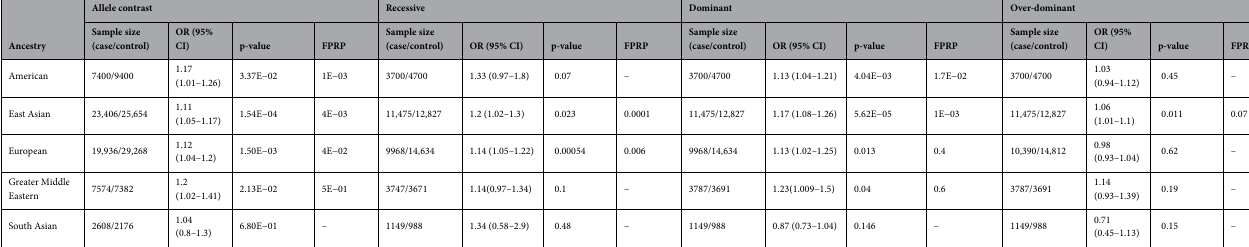
Table 3. Association meta-analysis of rs5219 in the subgroup analysis. The FPRP analysis was done for the significant associations. The FPRP level of noteworthiness is 0.2 OR odds ratio, CI confidence interval, FPRP false-positive report probability.